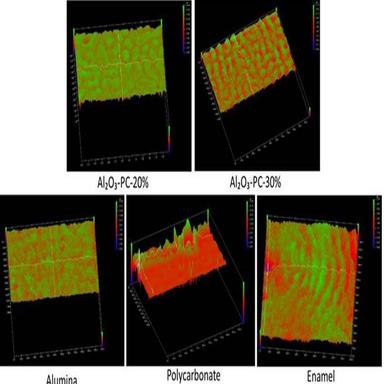
3D Profilometry images illustrating the effect of simulated toothbrushing in Al2O3-PC-20%, Al2O3-PC-30%, alumina, PC and enamel surfaces respectively.